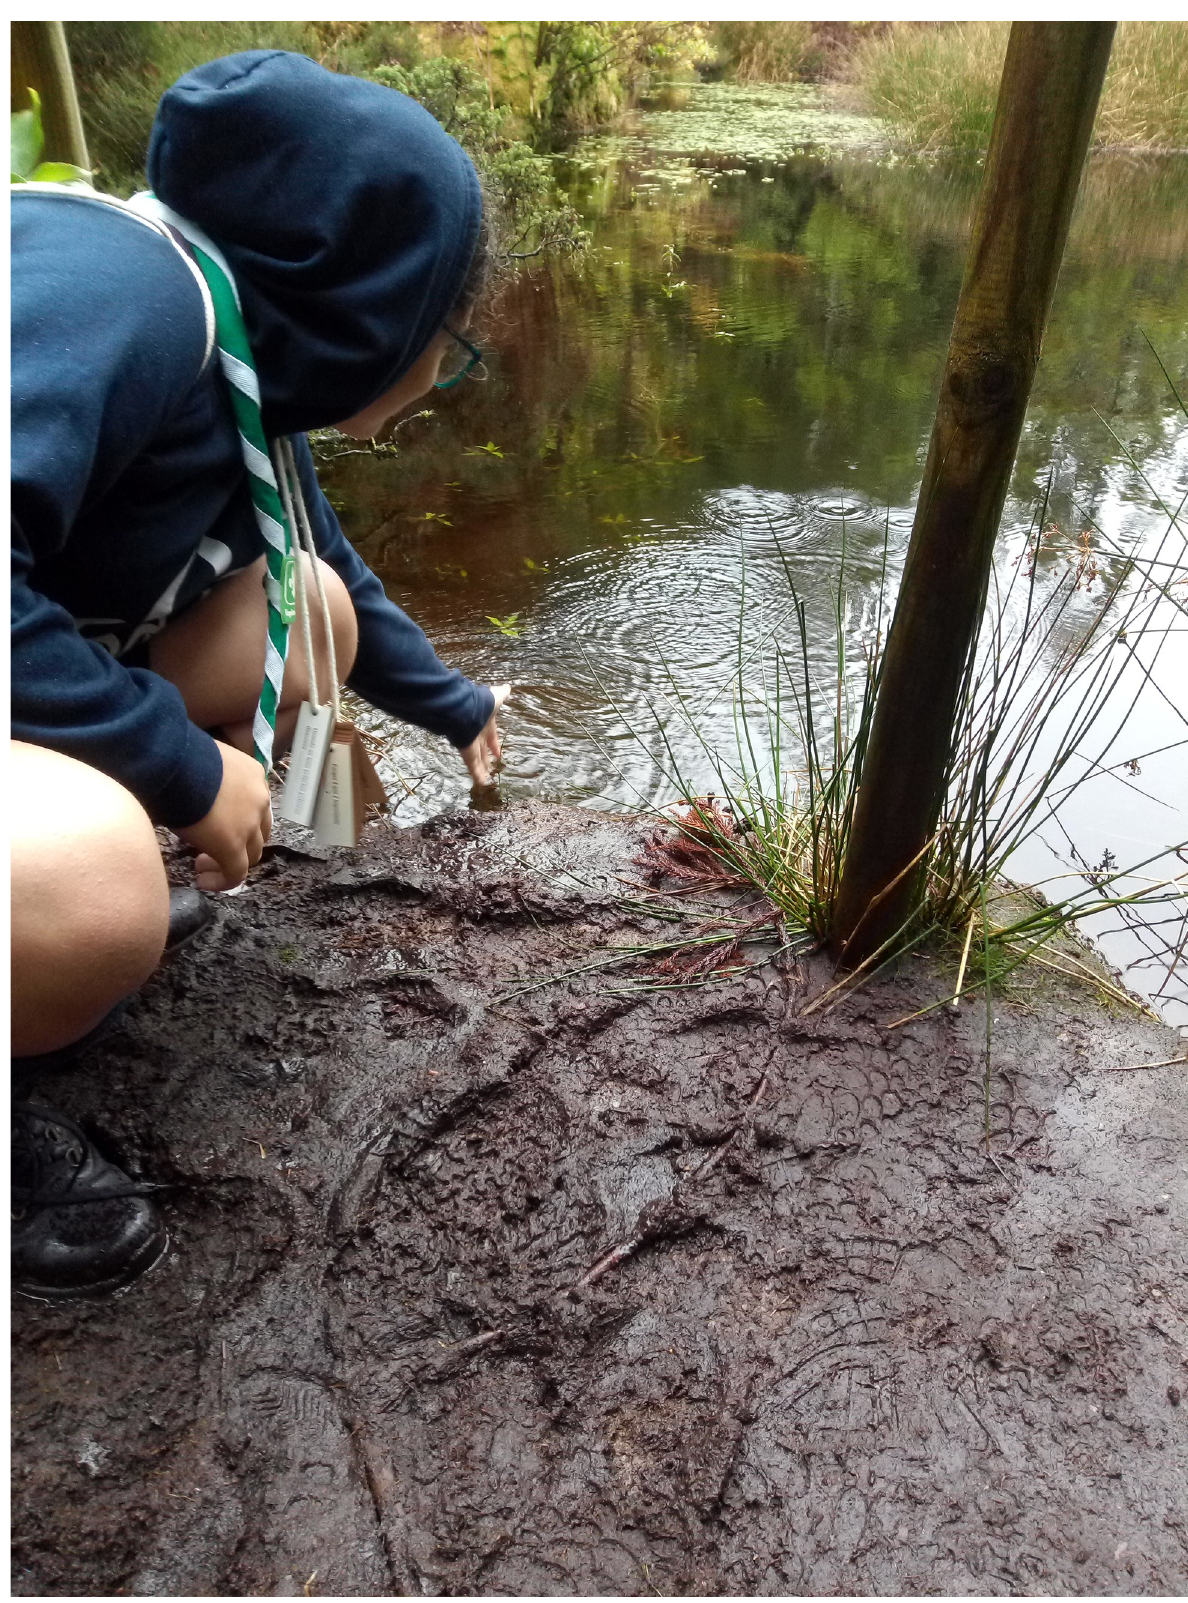
Fig 6. One participant touches water of the lagoon that can be found on the trail.